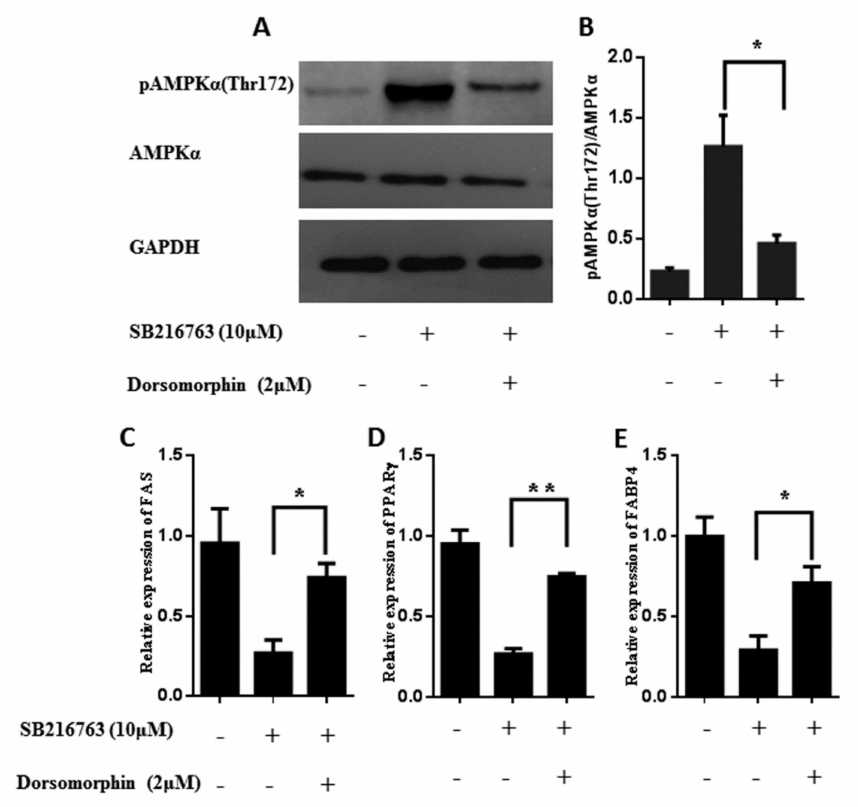
Figure 7. Inhibition of GSK3 β reduced the lipid accumulation in muscle satellite cells through the AMPK pathway. ( A , B ) Representative western blots and quantified results of pAMPK α (T172) during adipogenic di ff erentiation in muscle satellite cells for 4 days after SB216763 / dorsomorphin treatment. ( C , D , E ) The expression levels of adipogenic-regulated genes ( FABP4 , FAS and PPAR γ ) during adipogenic di ff erentiation for 4 days after SB216763 / dorsomorphin treatment. Error bars represent the SEMs of three separate experiments. ** p < 0.01; * p < 0.05 relative to SB216763 treatment